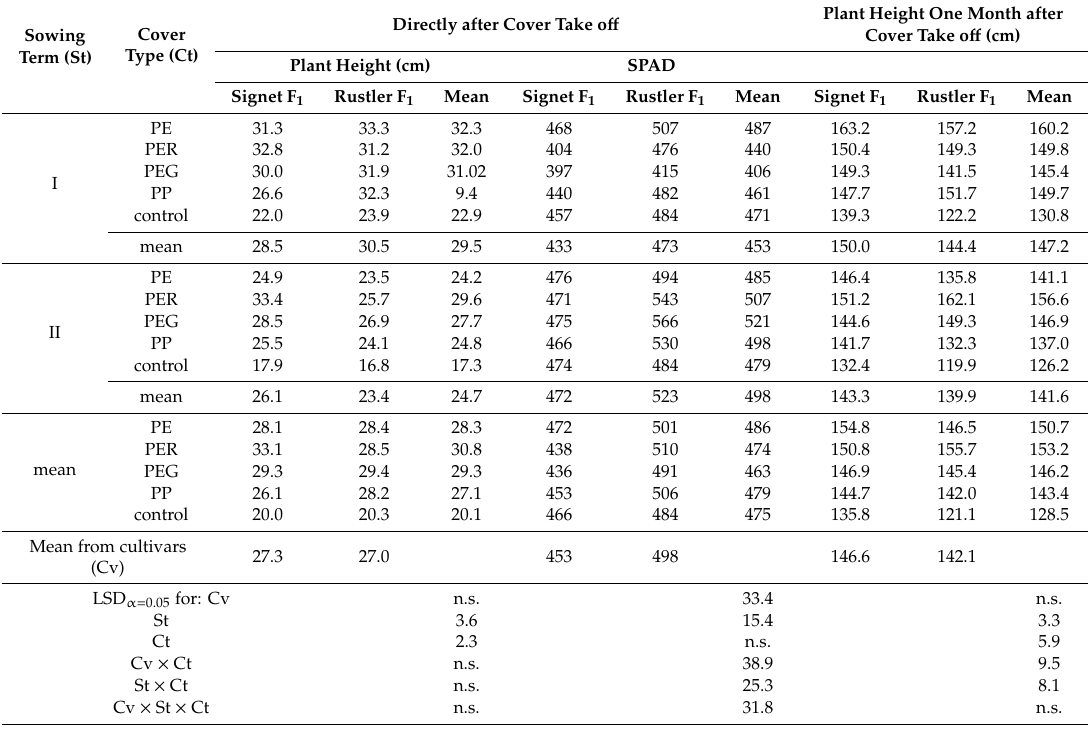
Table 4. The e ff ect of treatments on maize plants. Mean from the years 2012–2014. Sowing Term